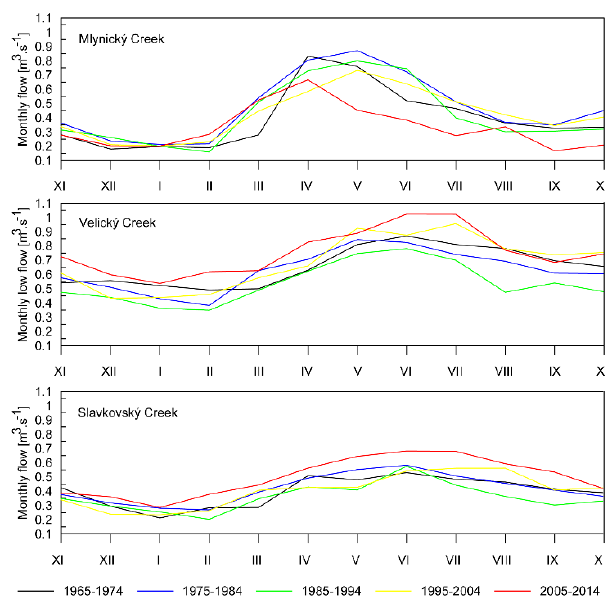
Figure 8. Medians of monthly flow characteristics observed in the decades from 1965–1974 to 2005– 2014.